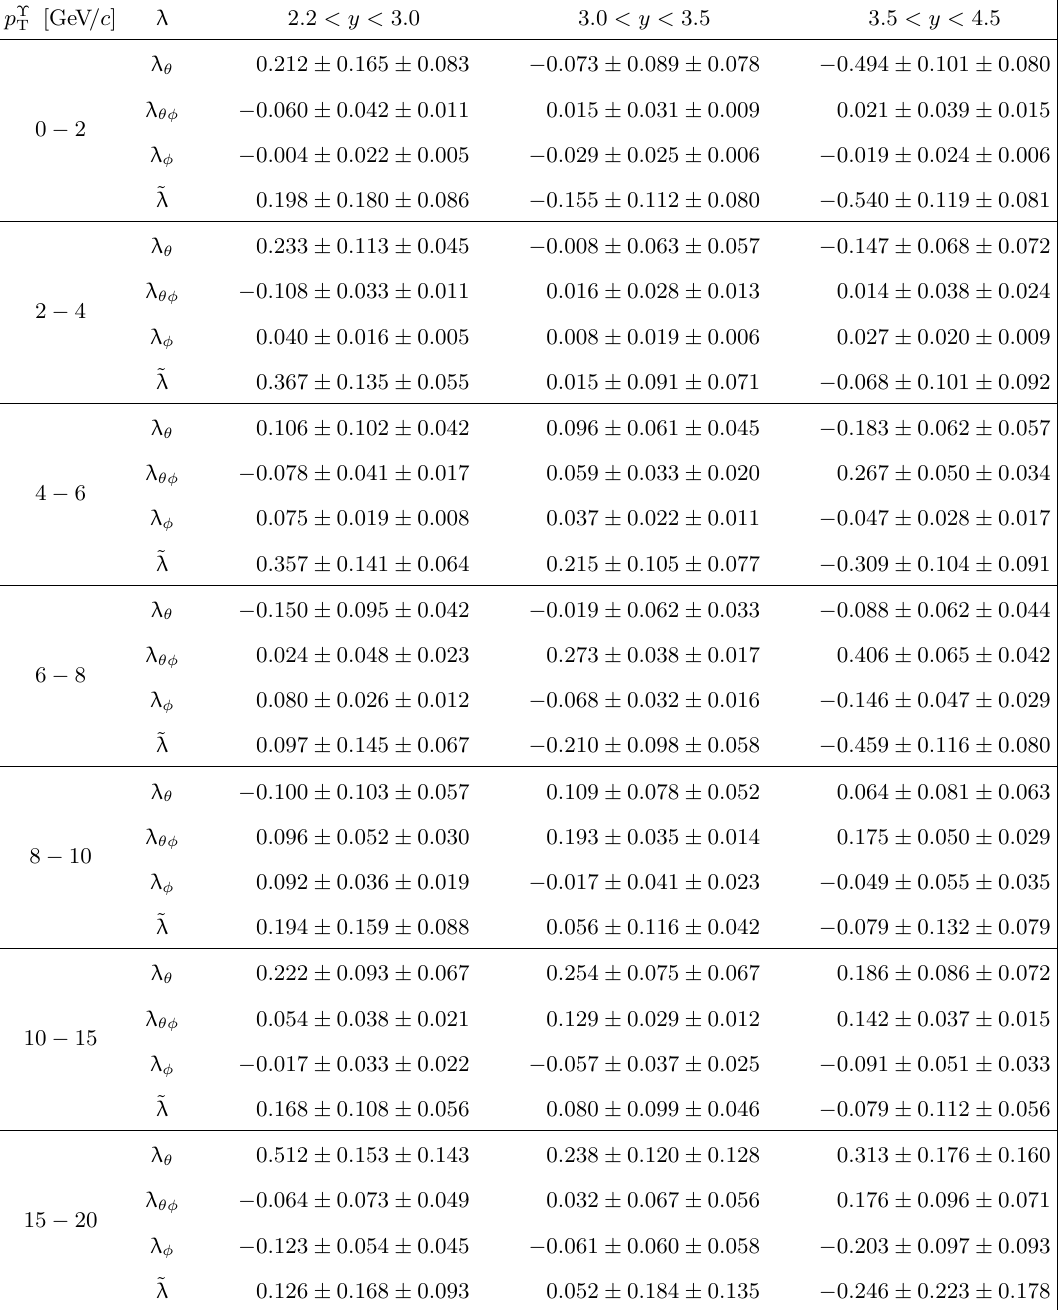
Table 21 . Values of (cid:21) (cid:18) , (cid:21) (cid:18)(cid:30) , (cid:21) (cid:30) and ~ (cid:21) measured in the HX frame for the (cid:7)(3S) produced at p s = 8 TeV. The (cid:12)rst uncertainty is statistical and the second systematic.